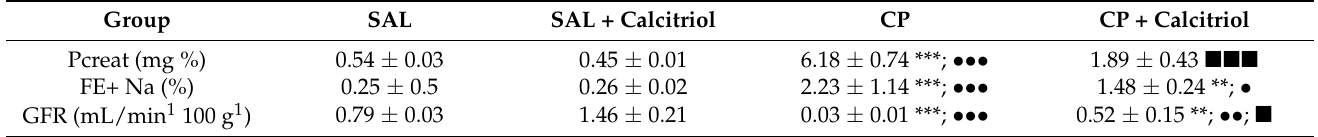
Table 1. Plasma creatinine (Pcreat), fractional sodium excretion (FE Na+ ) and glomerular filtration rate (GFR) 5 days after injection of CP or vehicle of the SAL ( n = 6), SAL + calcitriol ( n = 6), CP ( n = 8) and CP + calcitriol ( n = 8)